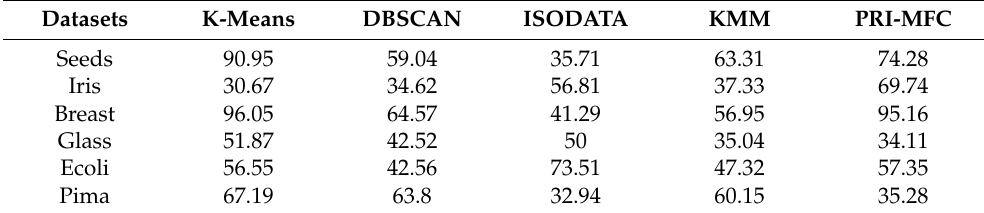
Table 5. ACC index values of five algorithms on the UCI datasets (%).